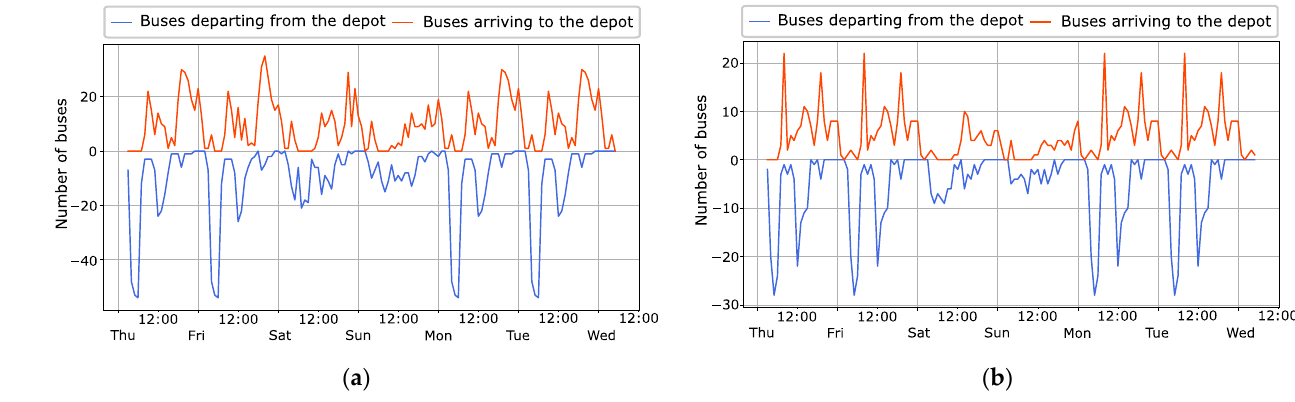
Figure 2. The number of departures and arrivals for a whole week for ( a ) BD1 and ( b ) BD2.